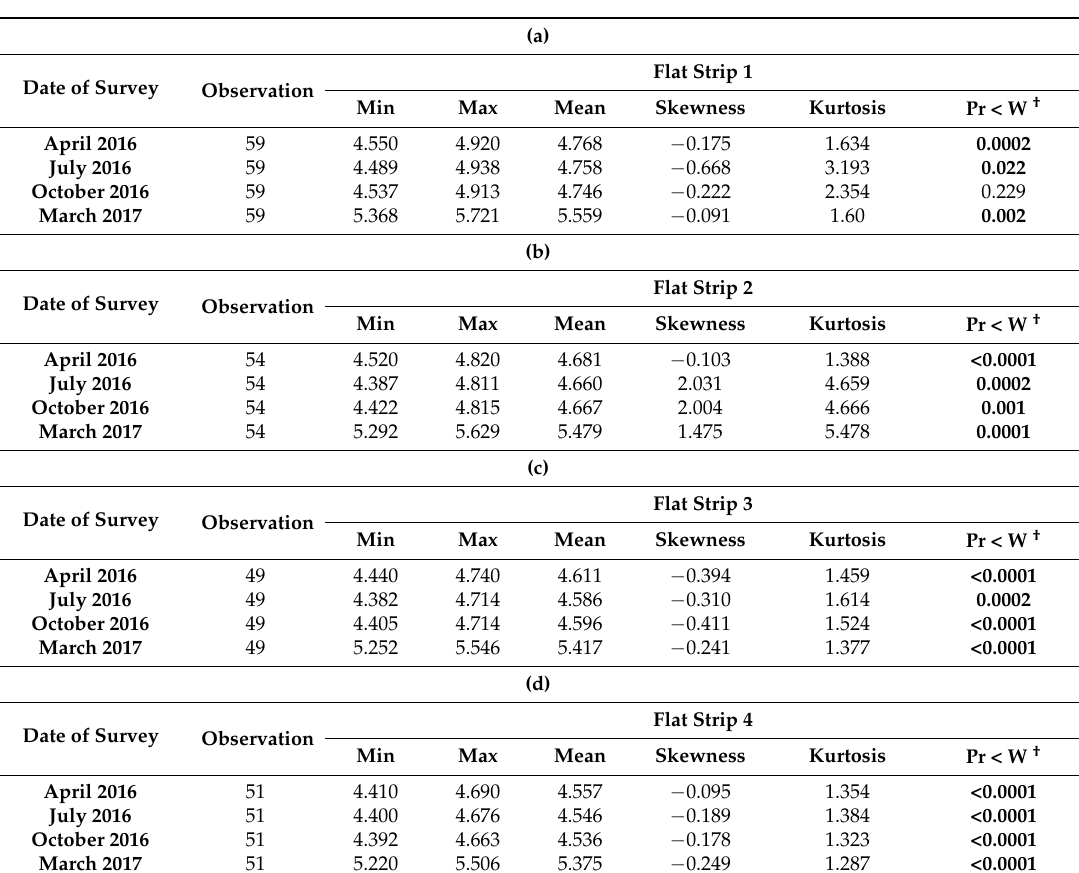
Table 3. Descriptive statistics of elevation (m a.s.l.) for ( a ) the first; ( b ) second; ( c ) third and ( d ) fourth (no LM control) strip in April 2016, July 2016, October 2016 and February 2017. Results of the Mann-Whitney test ( e